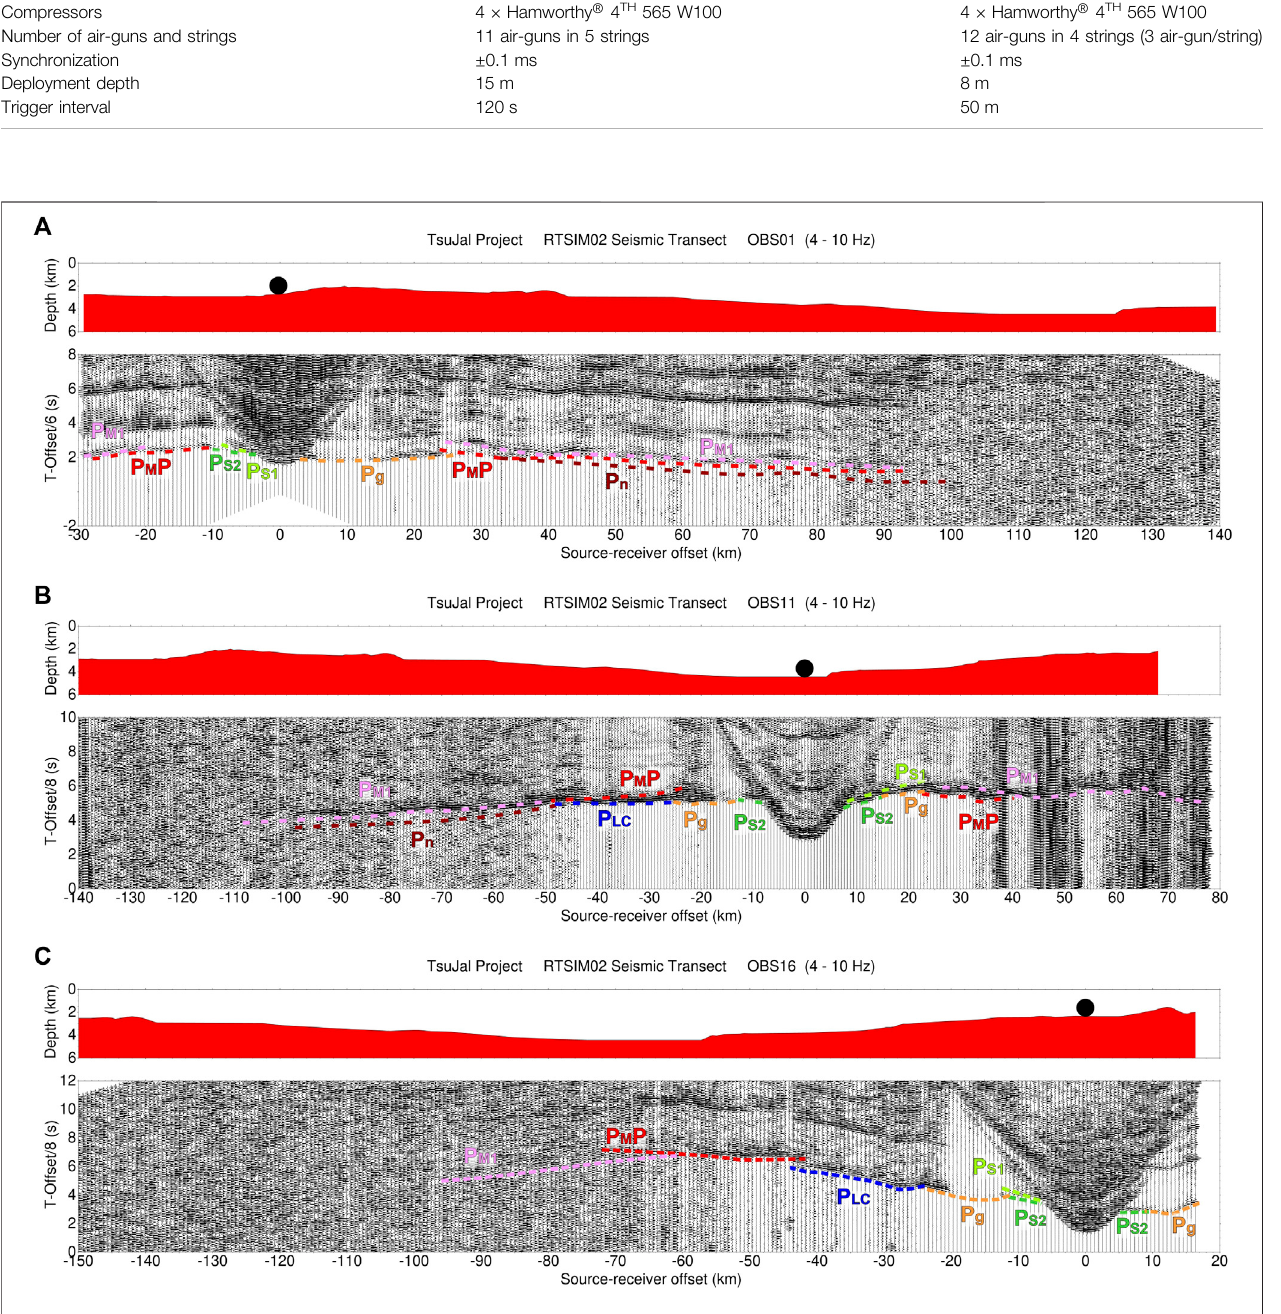
Frontiers in Earth Science |